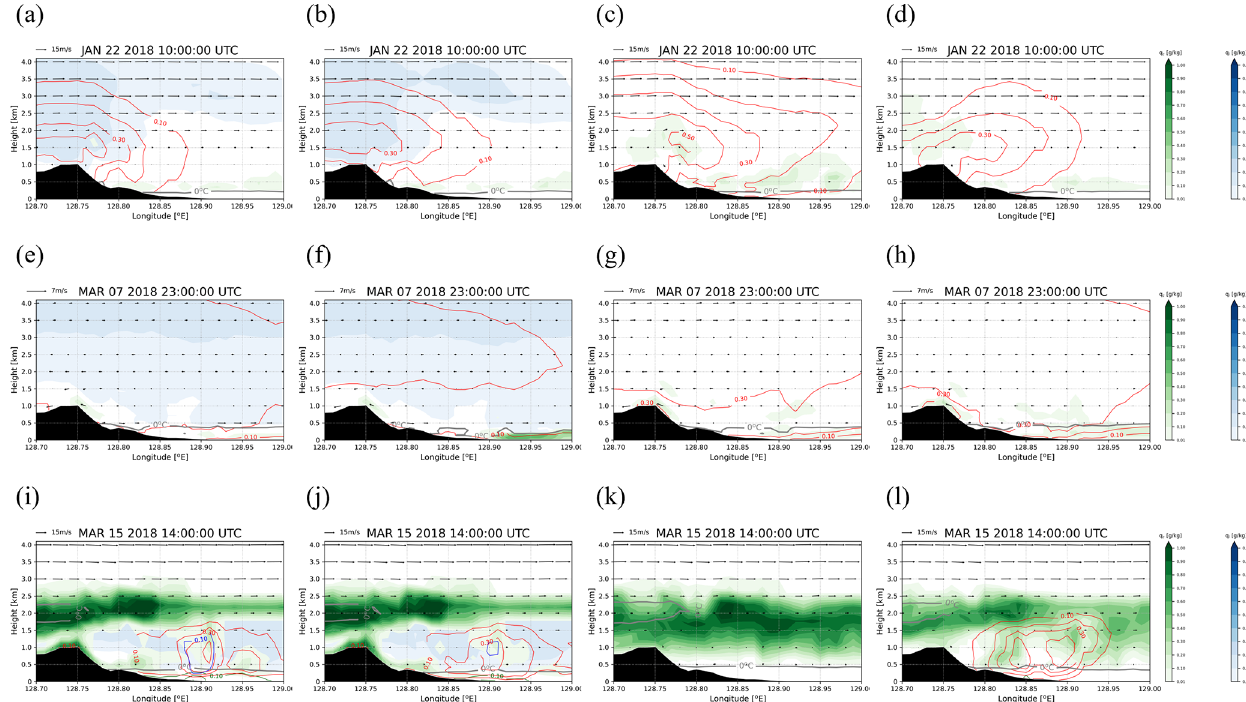
Figure 7. Terrain and the simulated hydrometeor mixing ratio (gkg − 1 ) along the cross section between GWU and MHS sites for (a–d) case 3, (e–h) case 6, and (i–l) case 7. From left to right, columns indicate the simulation results with the WDM6, WDM7, Thompson, and Morrison schemes, respectively. Shaded green and blue areas indicate the cloud water and ice mixing ratios, respectively. Red, blue, and black contours are for the snow, graupel, and hail mixing ratios. The contour levels are in 0.1gkg − 1 increments and the contour labels are in 0.2gkg − 1 increments starting from 0.1gkg − 1 . The solid gray line represents the 0 ◦ C line. The wind fields are overlaid at the same